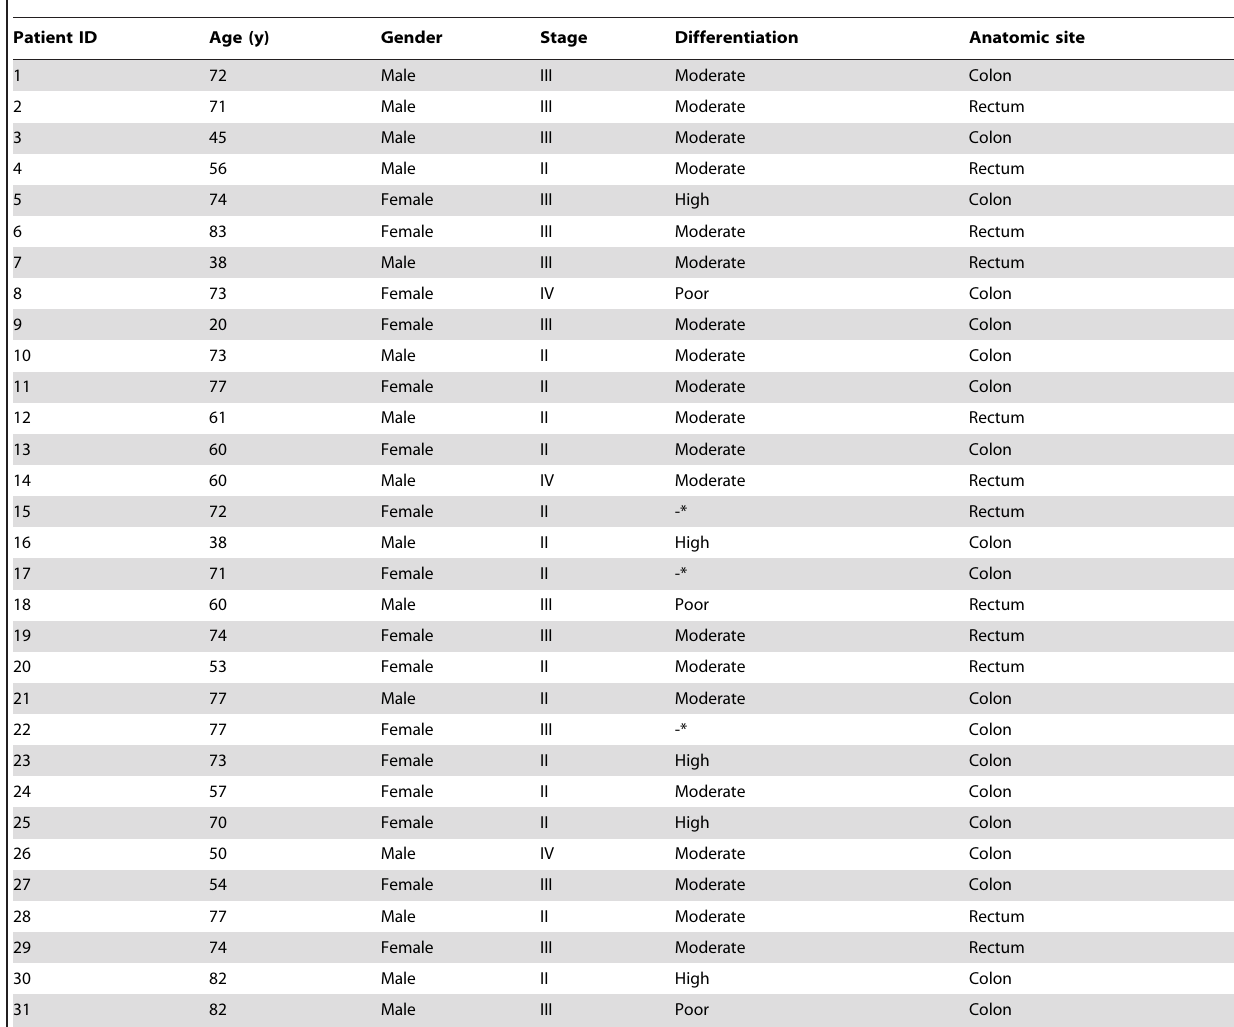
Table 1. Clinical and histopathological characteristics of